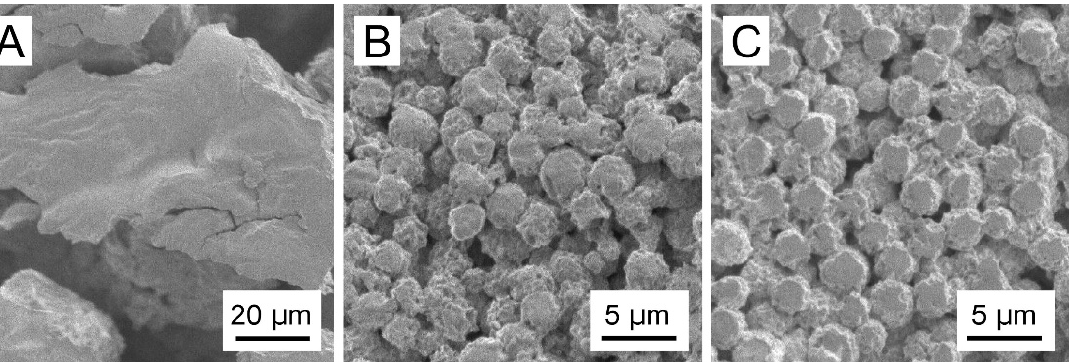
Figure 4. SEM images of ( A ) the white solid formed from PLL(Ns) nanoparticles devoid of CRG, ( B ) CRG(CS(Ns), Mb) microparticles, and ( C ) CRG(PLL(Ns), Mb) microparticles.